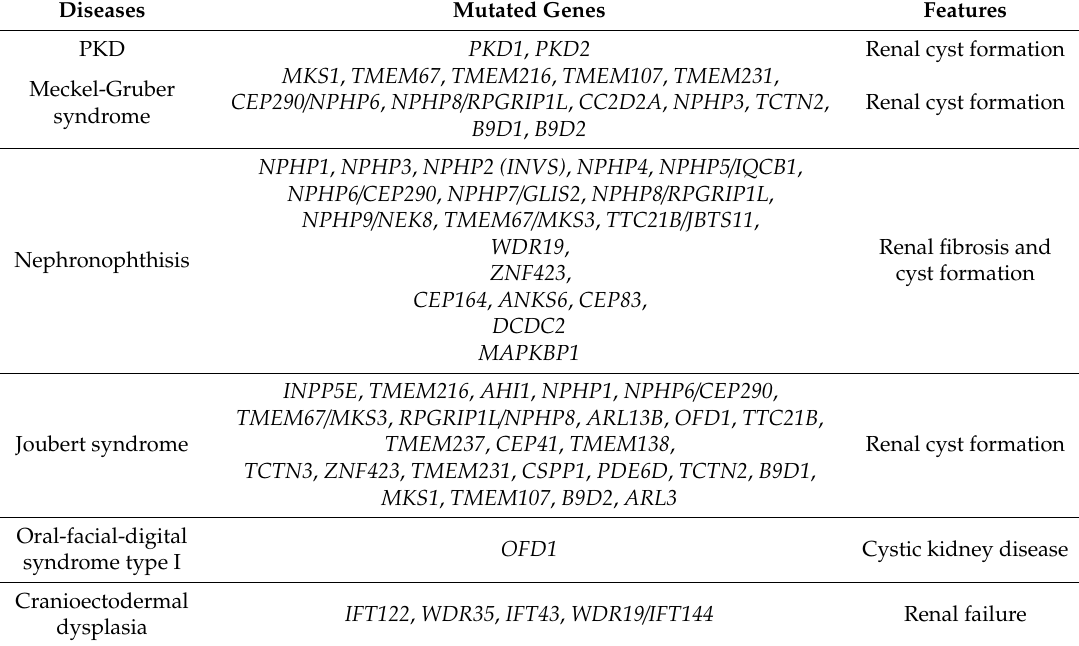
Table 1. Cilia and renal cysts-associated